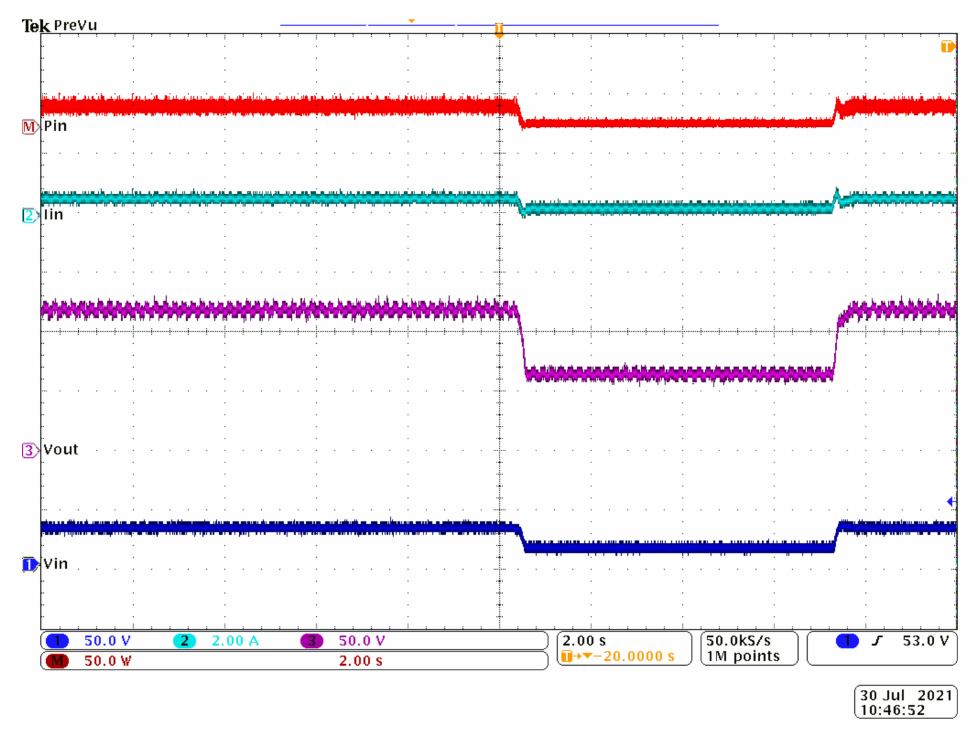
Figure 30. Oscilloscope waveforms for: input voltage “ Vin ”(dark-blue), output voltage “ Vout ”(purple), input current “ Iin ”(cyan) and input power “ Pin ”(red), in down to up